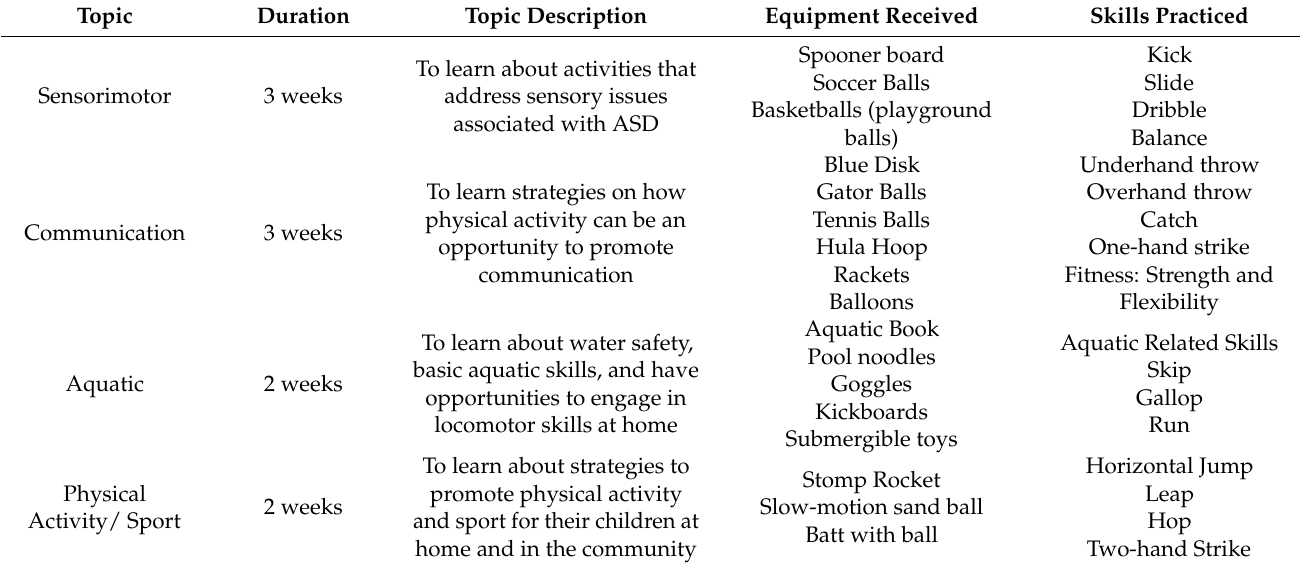
Table 2. Description of Intervention